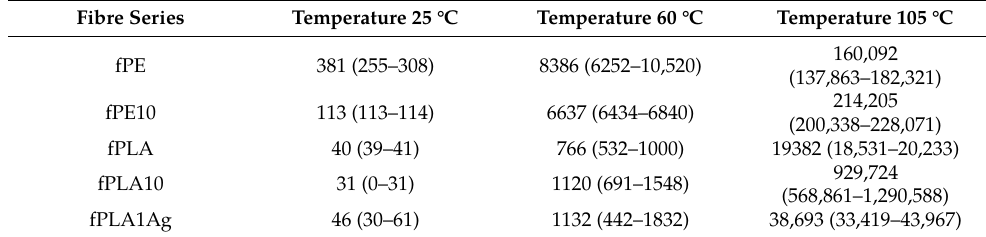
Table 6. Average and range (deviation) of total volatile organic compound (TVOC) (ng/L/g) measured from the parallel polyfilament samples at different temperatures. Collection between 6.0 and 36.4 min (retention time) per sample and temperature. Chromatograms are given in the Supplementary Material